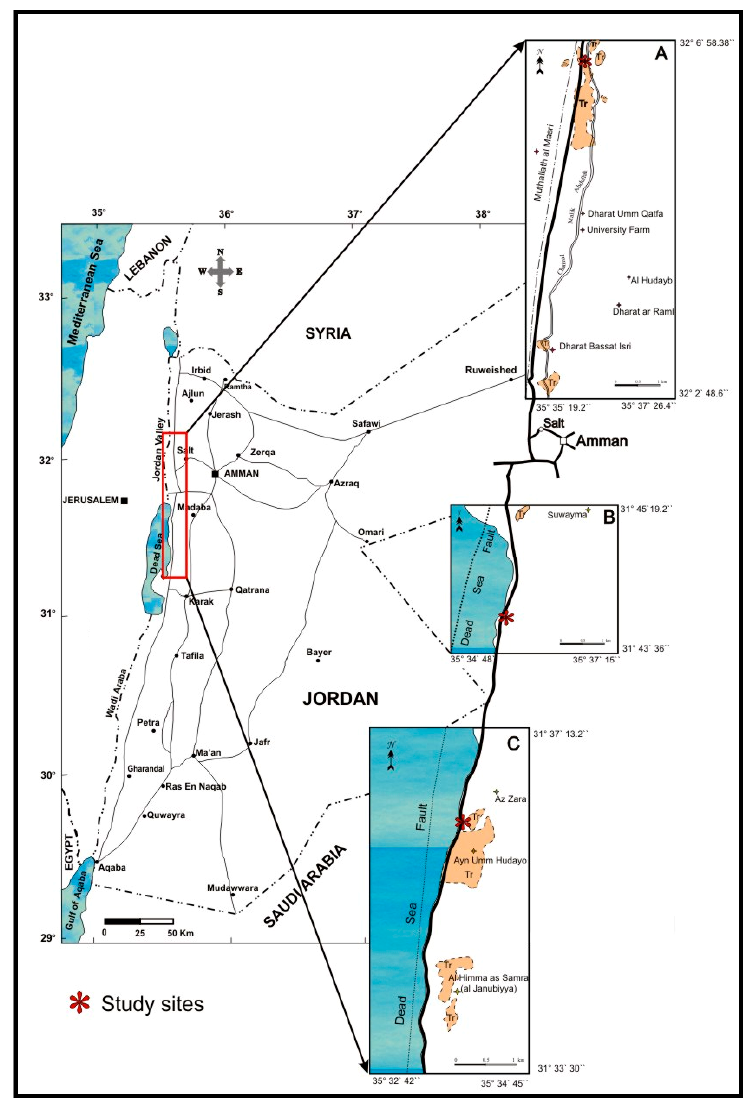
Figure 1. Location map to show the studied travertine outcrops.